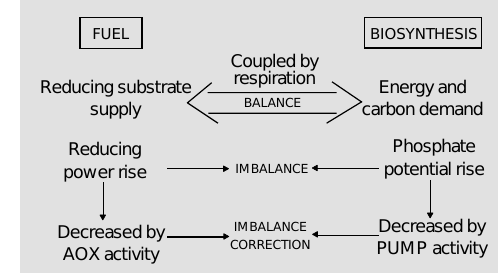
Figure 1 - Energy balance of the cell. Proposed roles of al- ternative oxidase (AOX) and plant uncoupling mitochon- drial protein (PUMP) in energy imbalance of cell metabolism (see